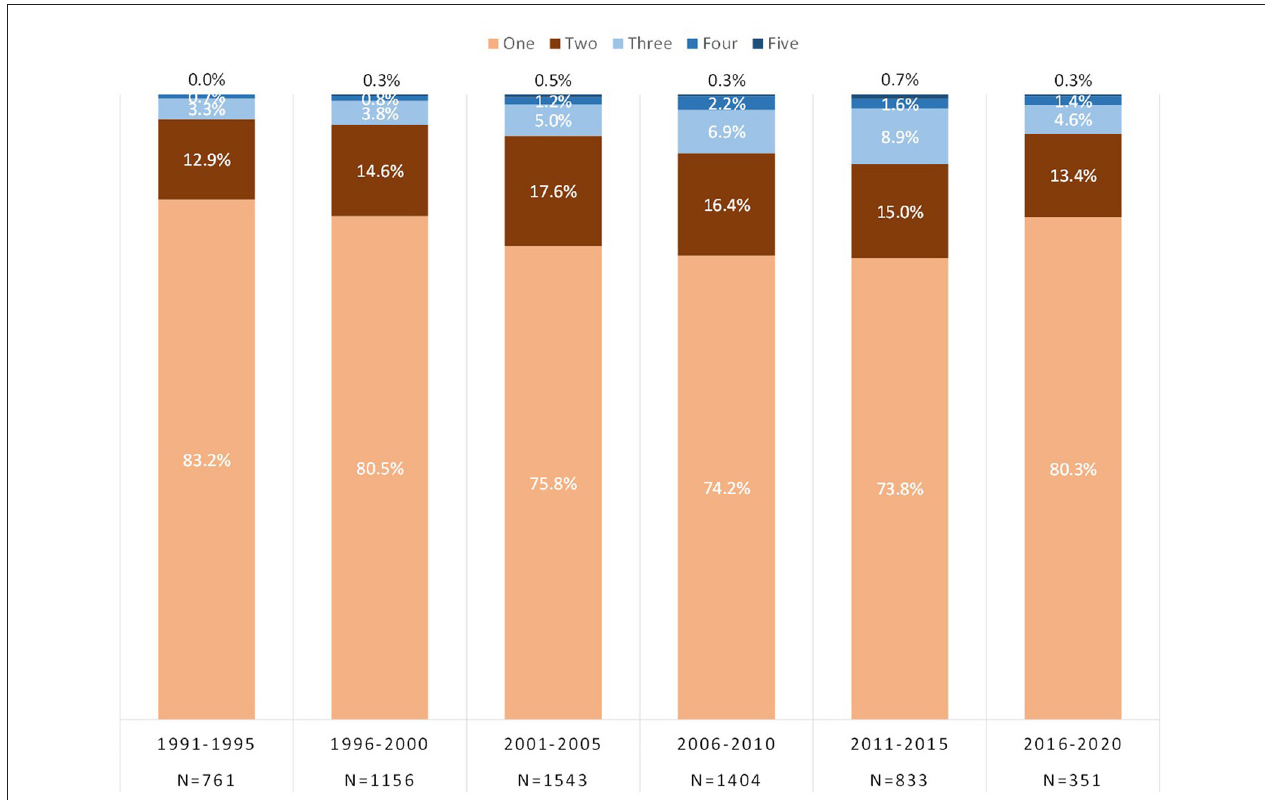
FIGURE 4 | Number of drugs (opioids and/or stimulants) used in the year of initial drug exposure.